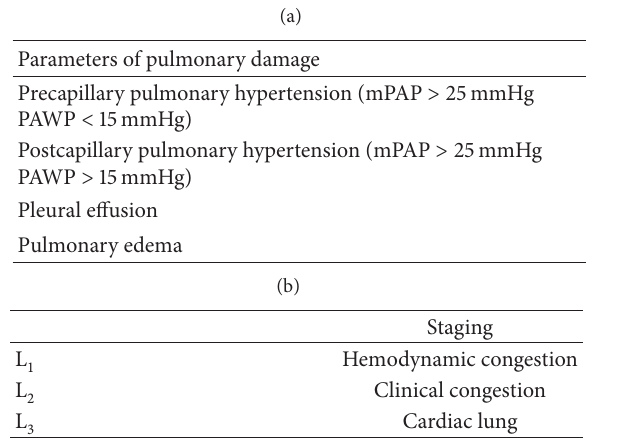
Table 2: (a) Schematic description of different pulmonary impli- cations occurring in patients with HF. (b) Severity stages of lung involvement.